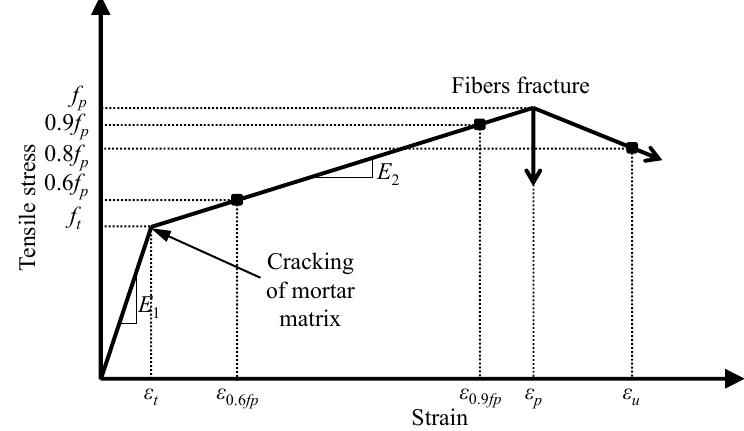
Figure 11. Idealized stress–strain curve of TRM test specimens.